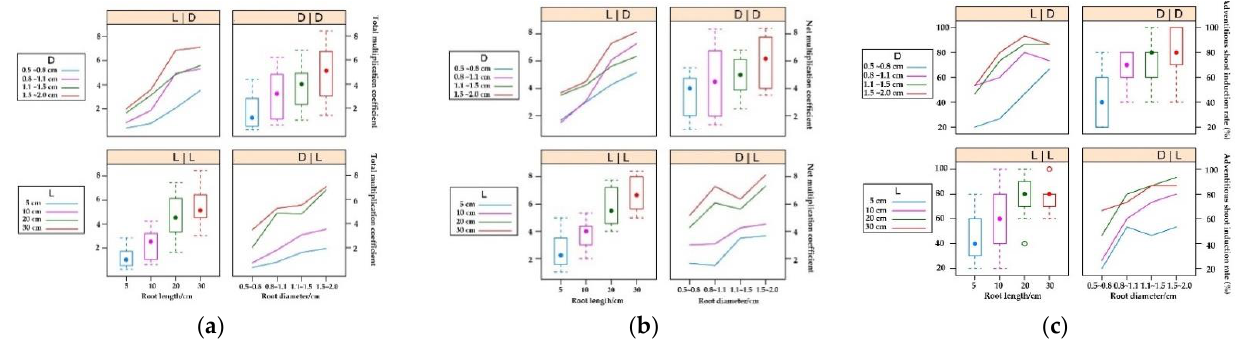
Figure 1. Main effects and 2-way interactions: ( a ) main effects and 2-way interactions of total multiplication coefficient; ( b ) main effects and 2-way interactions of net multiplication coefficient; ( c ) main effects and 2-way interactions of adventitious shoot induction rate. L: root length, D: root diameter, L/L: the main effect of root length, D/D: the main effect of root diameter, L/D and